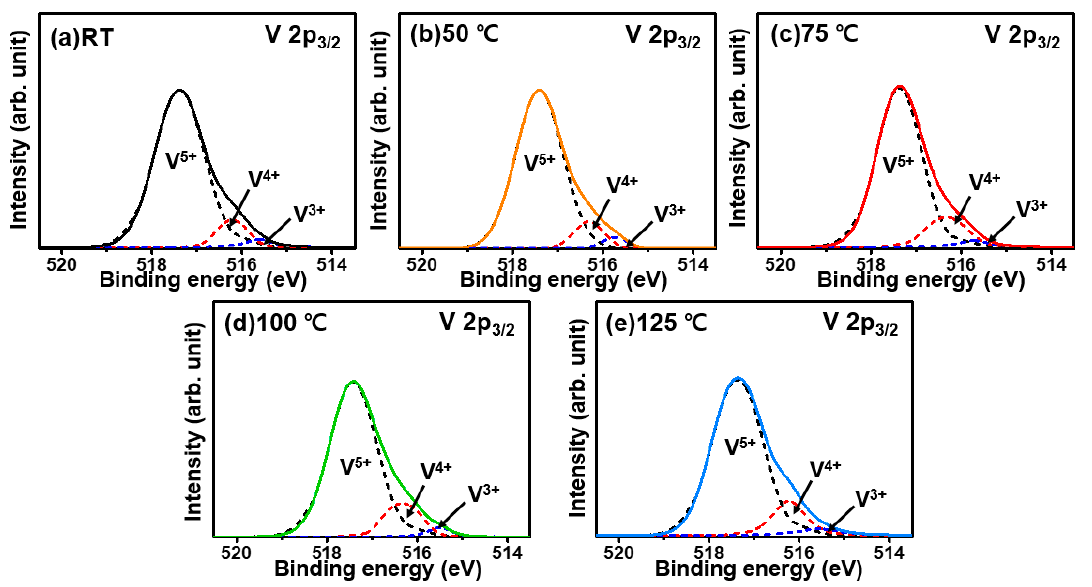
Figure 8. V 2p 3/2 XPS profiles of V 2 O 5 − x (15 nm) TFs deposited on Si surfaces at various deposition temperatures: ( a ) RT, ( b ) 50 ◦ C, ( c ) 75 ◦ C, ( d ) 100 ◦ C, and ( e ) 125 ◦ C.